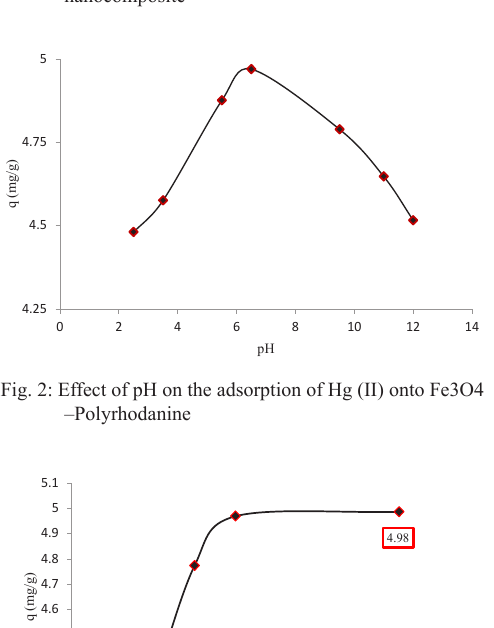
Fig. 1: a) TEM and b) FTIR images of polyrhodanine-Fe3O4 nanocomposite